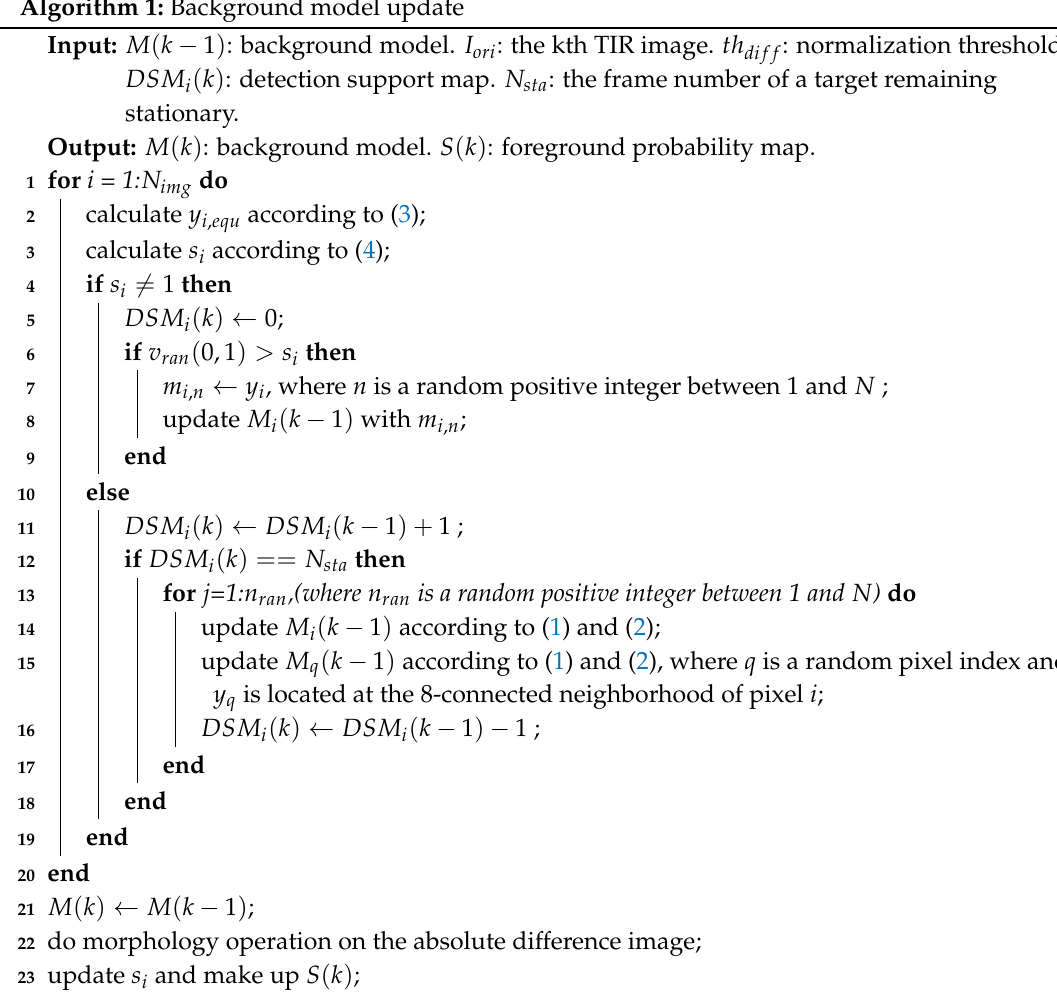
Algorithm 1: Background model